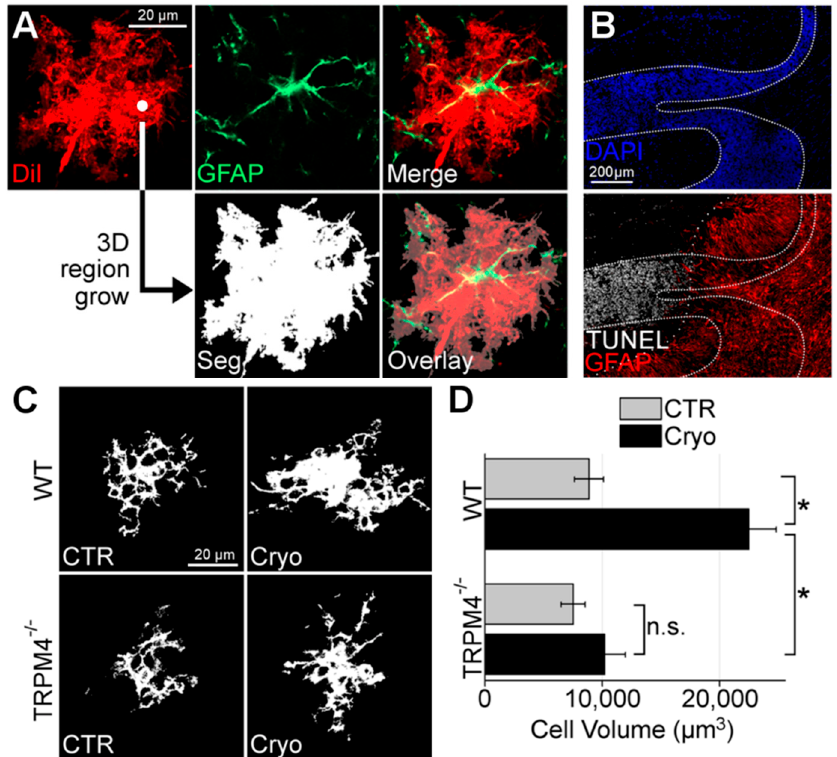
Figure 3. TRPM4 mediates astrocyte swelling after cerebellar cold injury. ( A ) Image processing pipeline for astrocyte volume quantification; DiI-stained (red), GFAP-positive (green) astrocytes were imaged; 3D region growing of DiI image outputs a binary image segmentation (Seg) of intracellular voxels (white) from extracellular voxels (black); overlay image of segmentation with DiI/GFAP image demonstrates full coverage of astrocyte arborization ( B ) Montage of micrographs of murine cerebellum with granule cell layer defined with DAPI (dense dotted lines) and co-labeled for GFAP (red) and TUNEL (white) showing TUNEL-positive granule cell layer tissues do not overlap (sparse dotted line) with GFAP-positive granule cell layer tissues; the results shown are representative of n = 4 mice. ( C ) Slices of segmented binary images of cerebellar granule cell layer astrocytes from wild-type (WT) and TRPM4 − / − mice submitted to control sham surgery (CTR) or cerebellar cold injury (Cryo) showing that in WT mice, granule cell layer astrocytes in cold injured cerebellum exhibited swelling of somata and processes, whereas astrocytes from TRPM4 − / − mice were protected from astrocyte swelling after cerebellar cold injury; the results shown are representative of n > 15 cells from 3 independent mice. ( D ) Quantification of granule cell layer astrocytic volume in WT and TRPM4 − / − mice submitted to sham surgery (CTR) or cerebellar cold injury (Cryo) showing that after cerebellar cold injury, WT astrocytes increased in volume from 8.86 × 10 4 µ m 3 to 22.47 × 10 4 µ m 3 ; TRPM4 − / − astrocytes increased in volume from 7.5 × 10 4 µ m 3 to only 10.2 × 10 4 µ m 3 ; TRPM4 knockout led to significant reduction in astrocyte swelling after cold injury; * p < 0.05 in ANOVA with Tukey tests between groups denoted with brackets; n.s. = non-significant; n > 15 cells from 3 different mice. From [23].